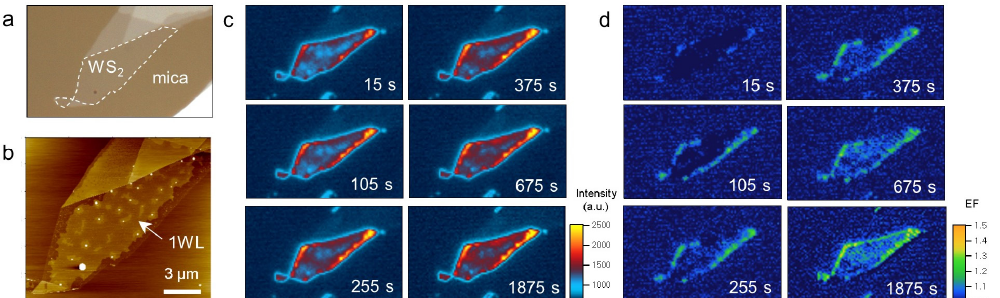
Figure 4. ( a , b ) Optical micrograph ( a ) and AFM height image ( b ) of 1L WS 2 /mica. ( c , d ) Time-lapse PL images ( c ) and PL enhancement images ( d ) of the sample in ( a ). The sample was pre-equilibrated with Ar gas for 2 h before exposure to Ar/O 2 mixed gas at time zero. The enhancement factor (EF) was calculated by normalizing each PL image with respect to that at time zero.